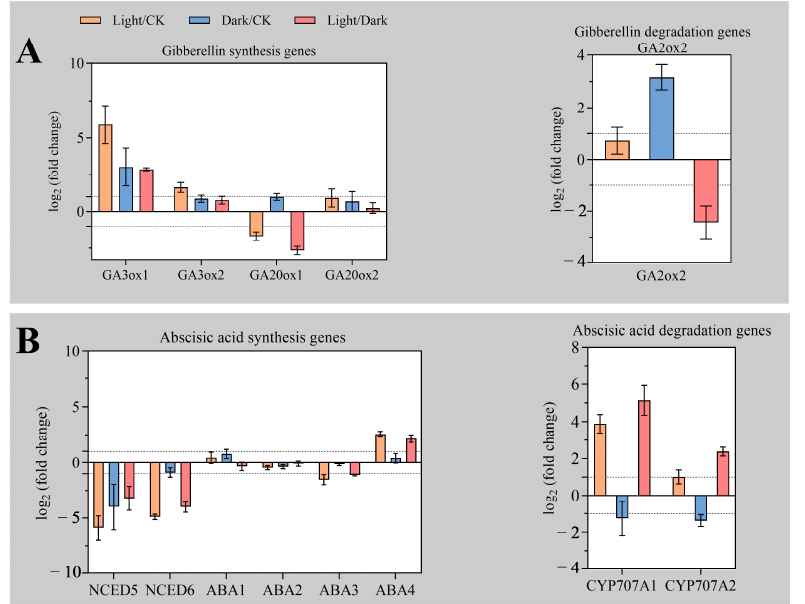
Figure 3. Expression level of plant hormone synthesis and degradation genes. ( A ) Expression level of gibberellin synthesis and degradation genes. ( B ) Expression levels of abscisic acid synthesis and degradation genes. Vertical bars indicate means ± SD ( n = 3).